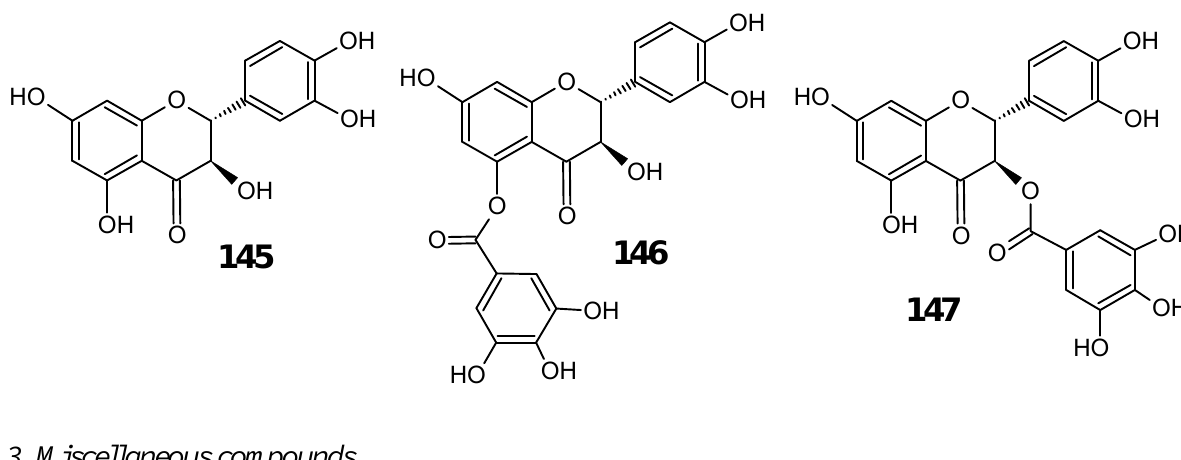
Figure 15. Antiplasmodial flavonoids 145-147